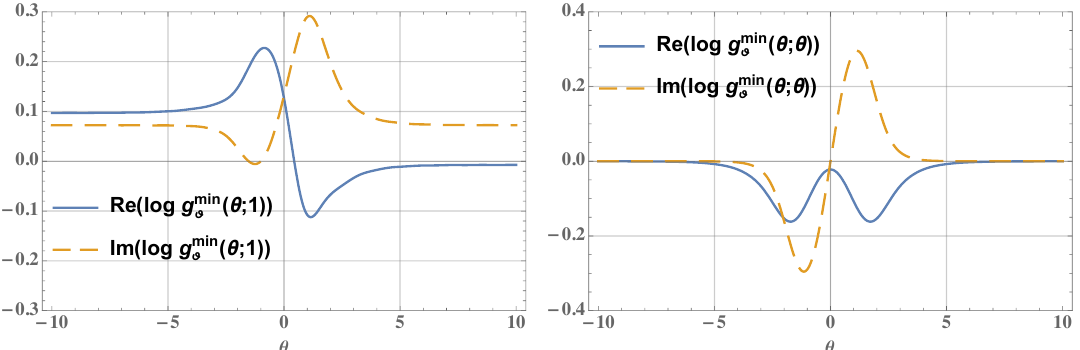
Figure 9. We plot the minimal two particle form factor normalized by the vacuum minimal form factor, de(cid:12)ned as g min ( (cid:18) 1 ; (cid:18) 2 ) (cid:17) f min ( (cid:18) 1 ; (cid:18) 2 ) =f min ( (cid:18) 1 (cid:0) (cid:18) 2 ). Both plots are again for the Sinh-Gordon # # model with interaction parameter B = 1 = 2 and at temperature (cid:12) = 1.